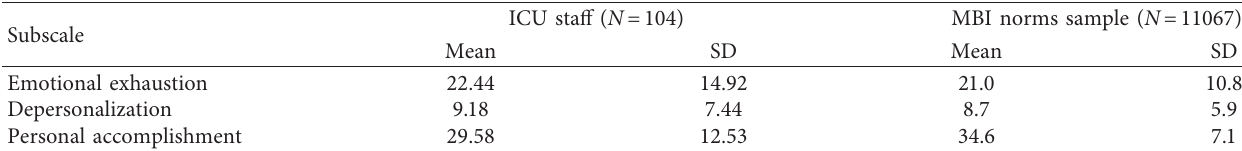
Table 2: Means and standard deviations for the subscale scores of ICU staff compared to the overall sample of Maslach burnout inventory norms.